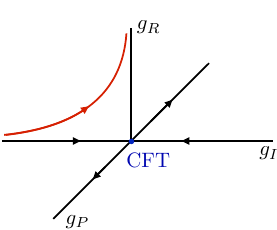
Figure 7 . The tuning mechanism for a weakly (cid:12)rst-order phase